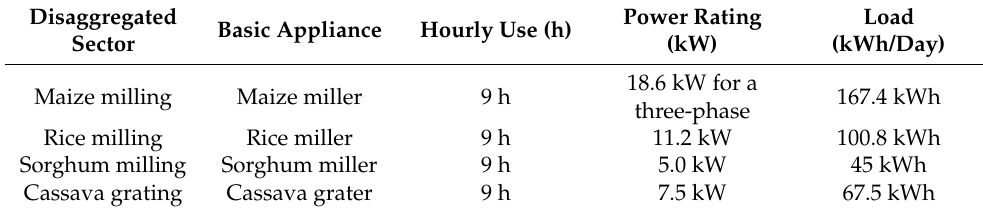
Table 15. Results of the survey on the category B productive use enterprise.